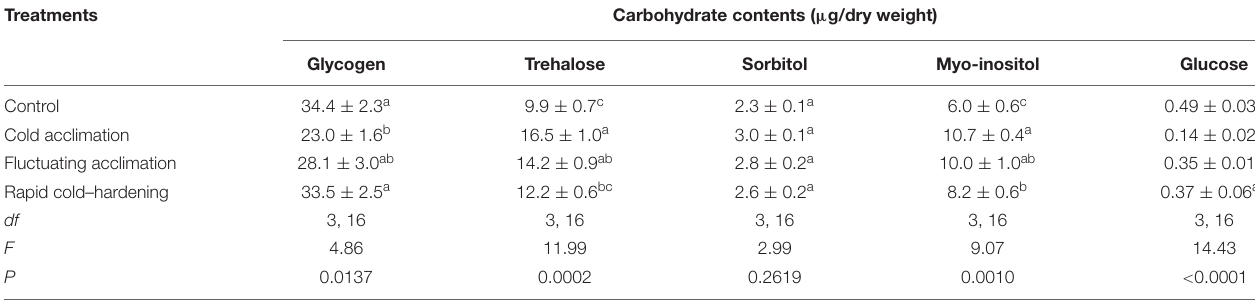
FIGURE 2 | Hemolymph Na + (A) and K + (B) concentrations before and immediately following 1, 2, 4, 6, and 12 h at –10 ◦ C in Trogoderma granarium fourth instar larvae following different thermal regimes. Each point is an average of five replications. The means followed by different letters are significantly different (Turkey’s test, P < 0.05). TABLE 1 | Carbohydrate contents ( n = 5) of Trogoderma granarium fourth instar larvae following different thermal